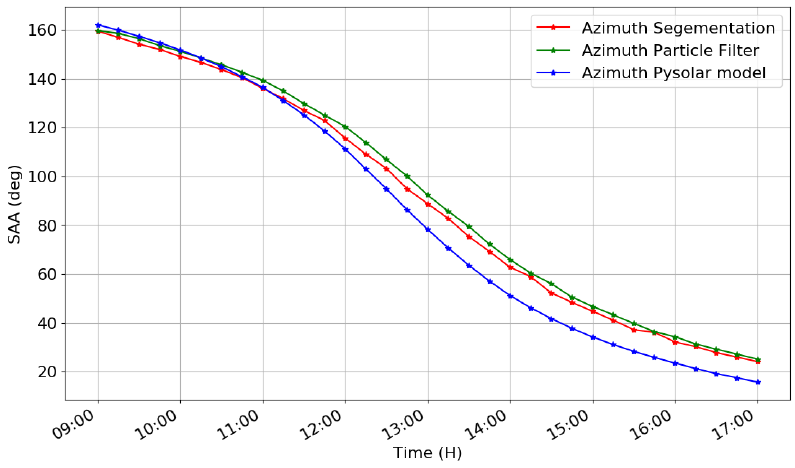
Figure 27. Solar azimuth angle